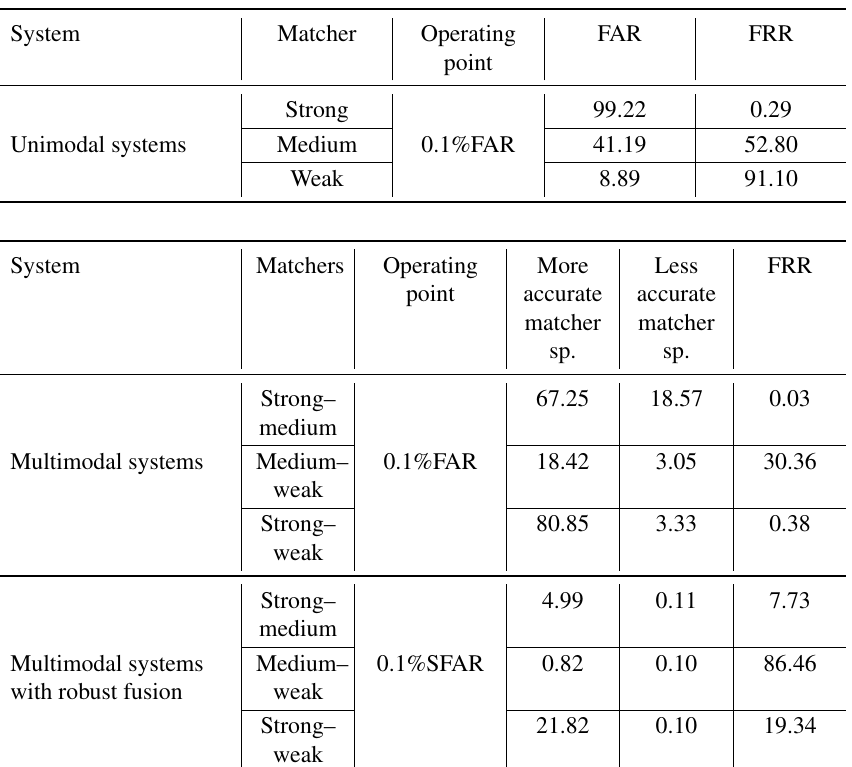
Table 7. FAR(%) and FRR(%) against spoof attack of unimodal system (top), mul- timodal systems and multimodal systems with enhanced fusion (bottom), at 0.1% FAR and SFAR operating points,